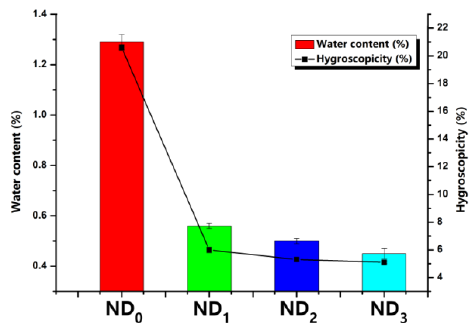
Figure 6. Water content and hygroscopicity results of different NTM DPIs ( n = 3).